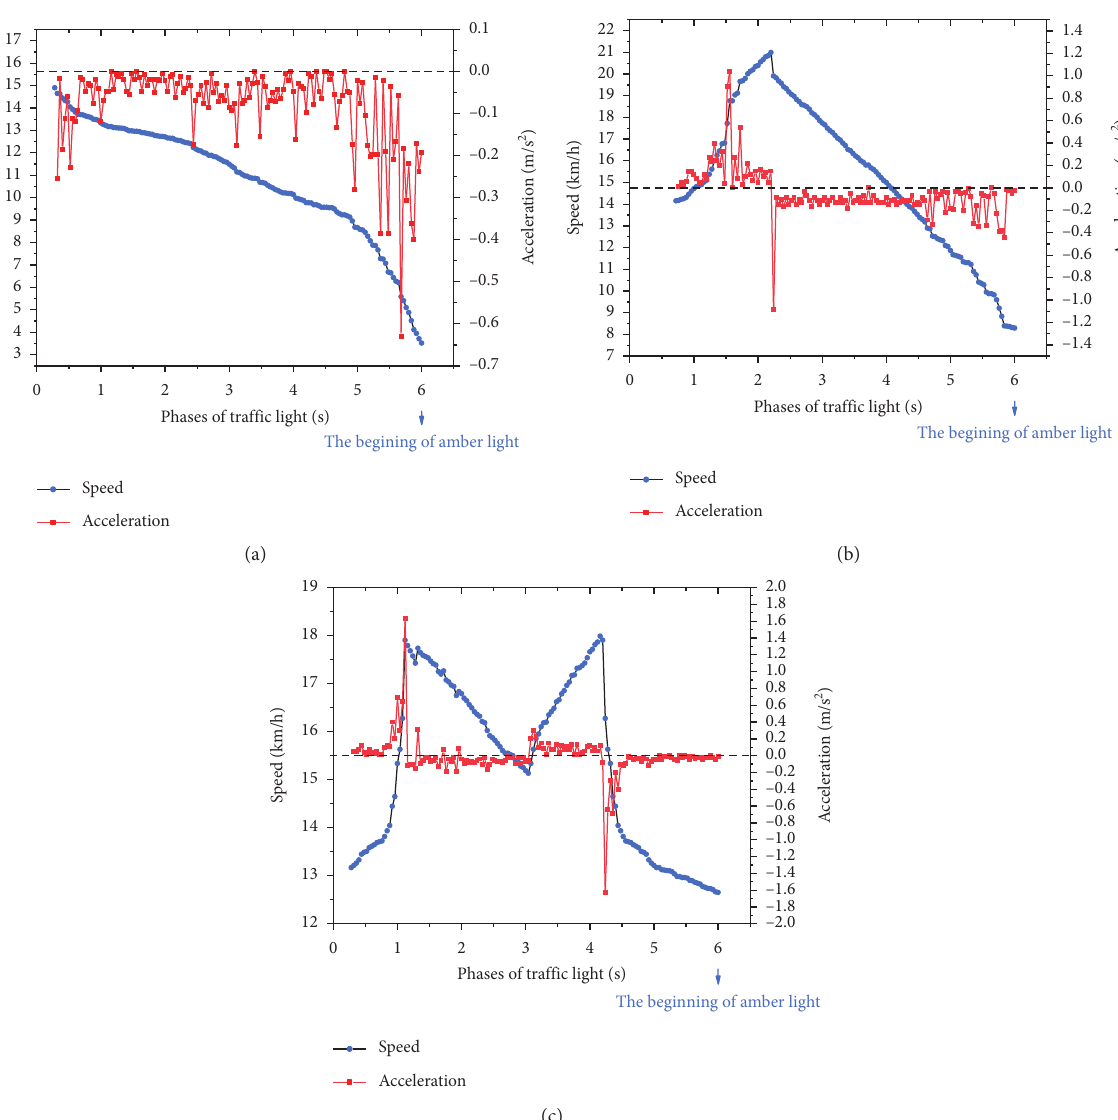
Figure 4: Typical approaching speed and acceleration rate profile of NYLS, AYLR, and CYLS